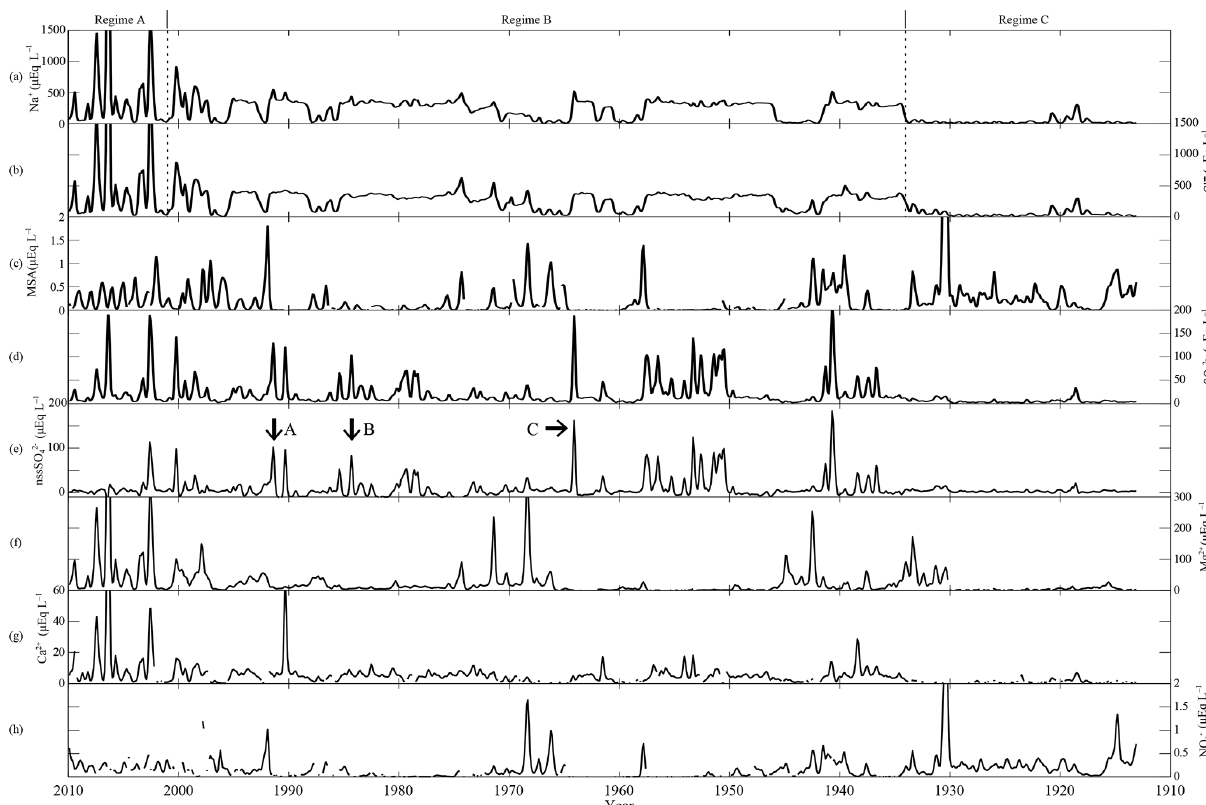
− , (e) nssSO 2 − , (f) Mg, (g) Ca, and (h) NO 3 . All data were 4 4 record correspond to major volcanic eruptions (Pinatubo (1991), El 4